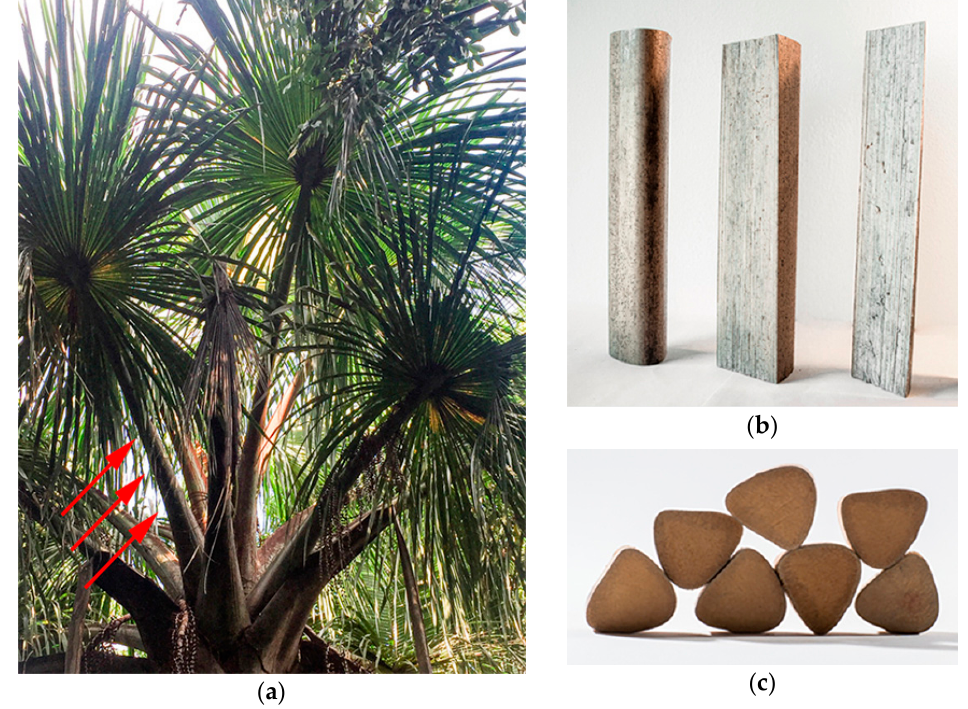
Figure 1. Buriti foam: ( a ) palm leaves with red arrows highlighting the petiole from which the vegetable foam is taken, ( b ) petiole longitudinal section, and ( c ) petiole cross ‐ section.